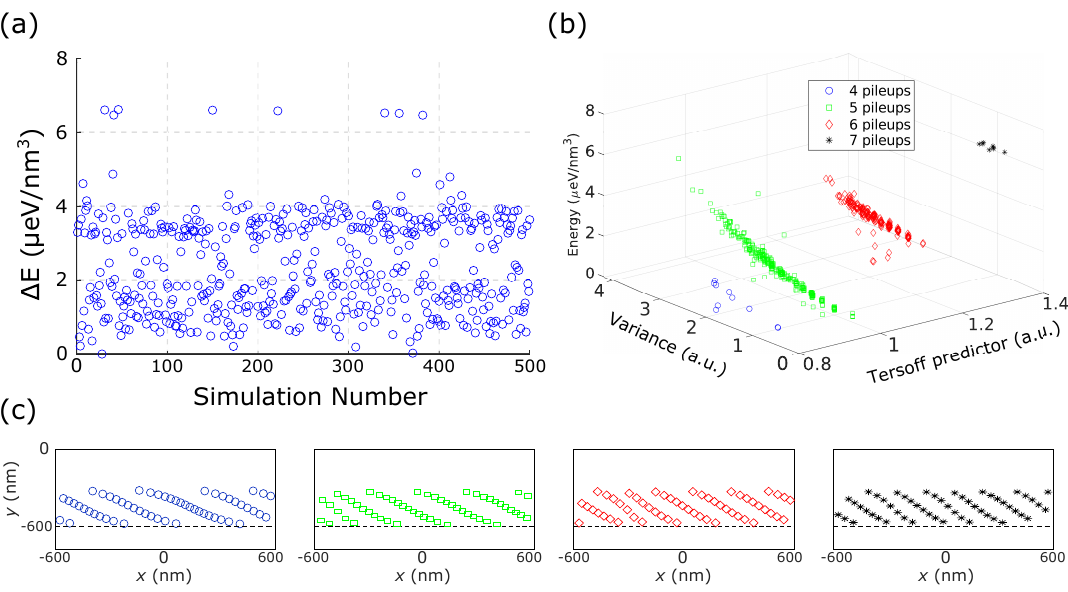
Figure 6. Comparison with Tersoff mean field model. The energies of the 500 collected local minima (relative to the lowest) ( a ). Total energy of the obtained minimum configurations plotted against the value of our Tersoff predictor and the variance of the dislocation number per pile-up ( b ). Results naturally cluster into subsets of minima depending on the number of pileups that remain in the cell. The insets ( c ) show examples of the dislocation configurations belonging to each of the subsets found, with the corresponding